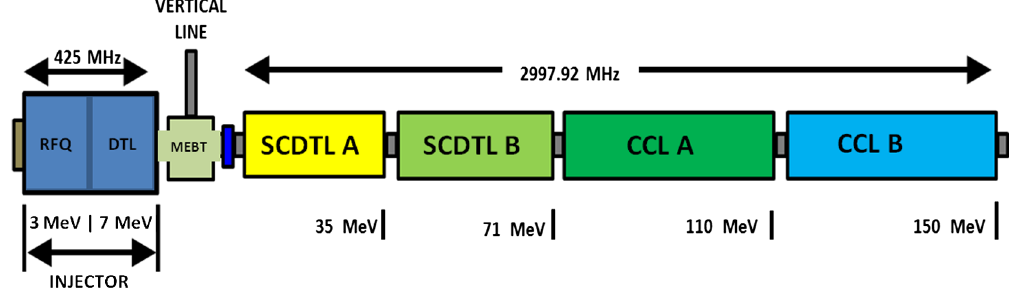
FIG. 1. Schematic layout of the TOP-IMPLART